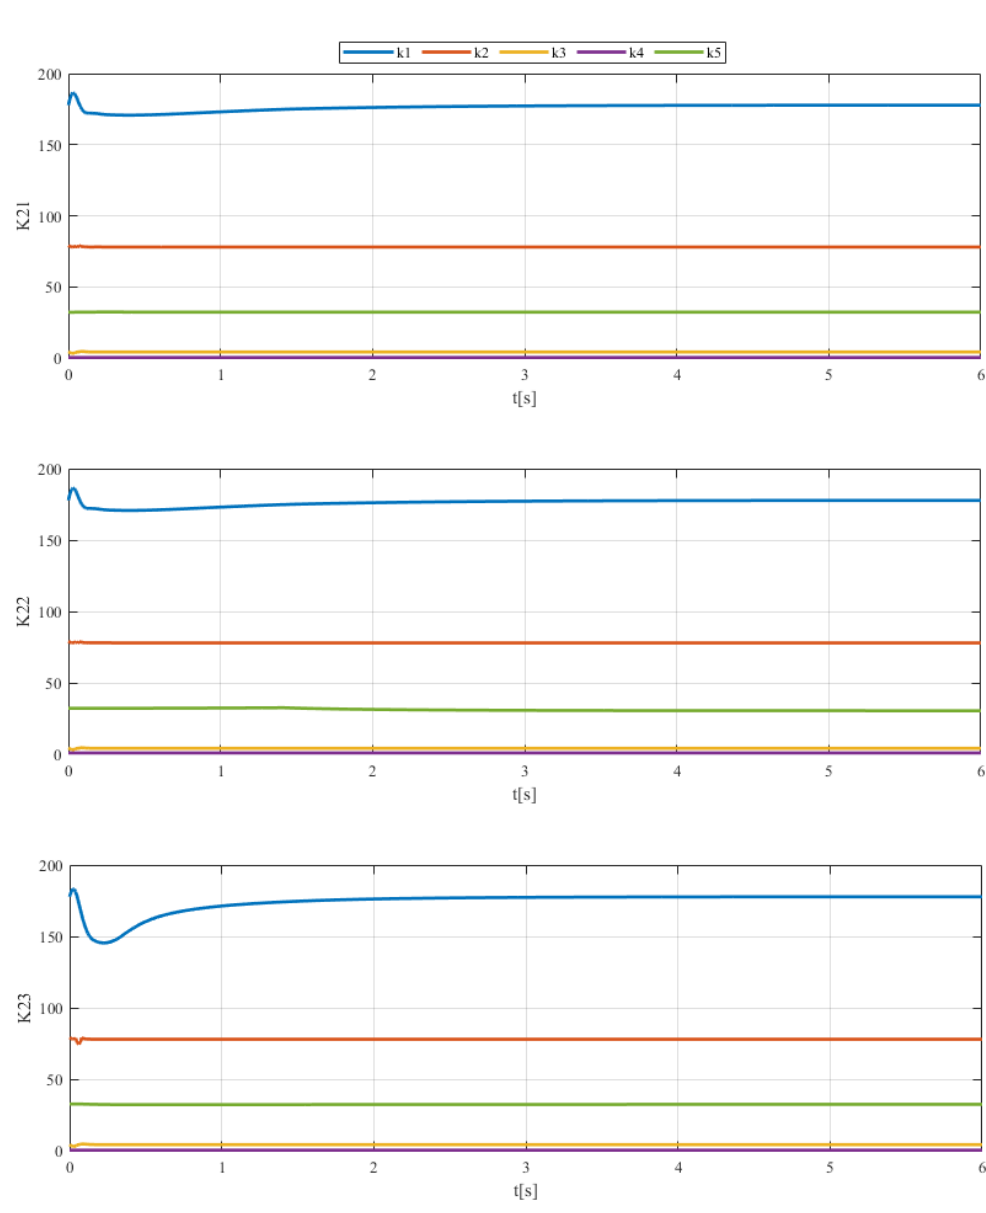
Figure 8. Controller gains of FLC for K21 (scenario 2, area 1), K22 (scenario 2, area 2), and K23 (scenario 2, area